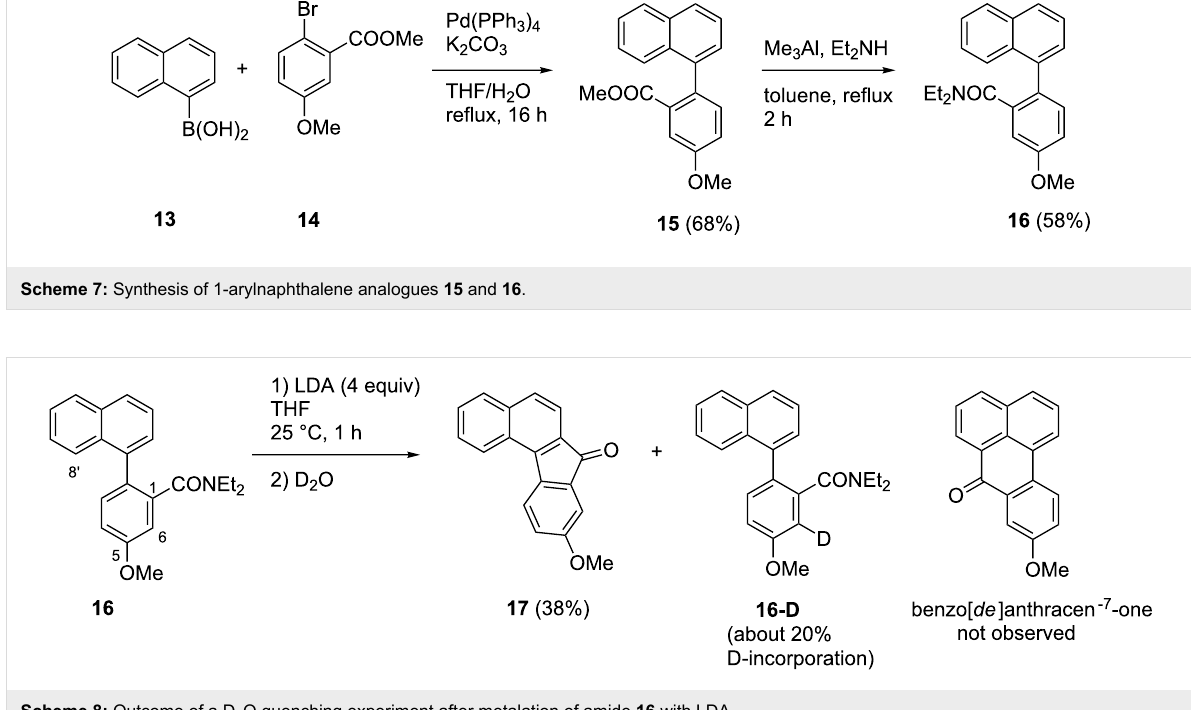
Scheme 8: Outcome of a D 2 O quenching experiment after metalation of amide 16 with